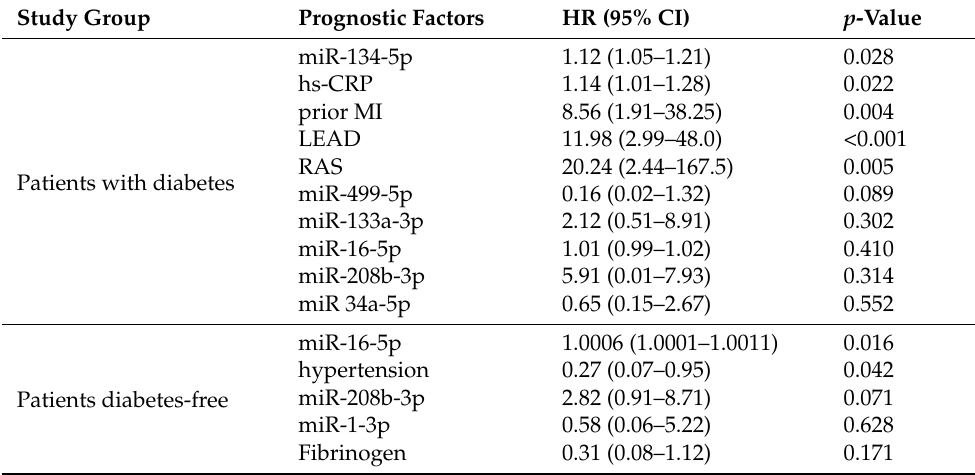
Table 3. Multivariate Cox analysis for cardiovascular outcome in diabetic and non-diabetic patients for parameters that were significant in the Univariate Cox